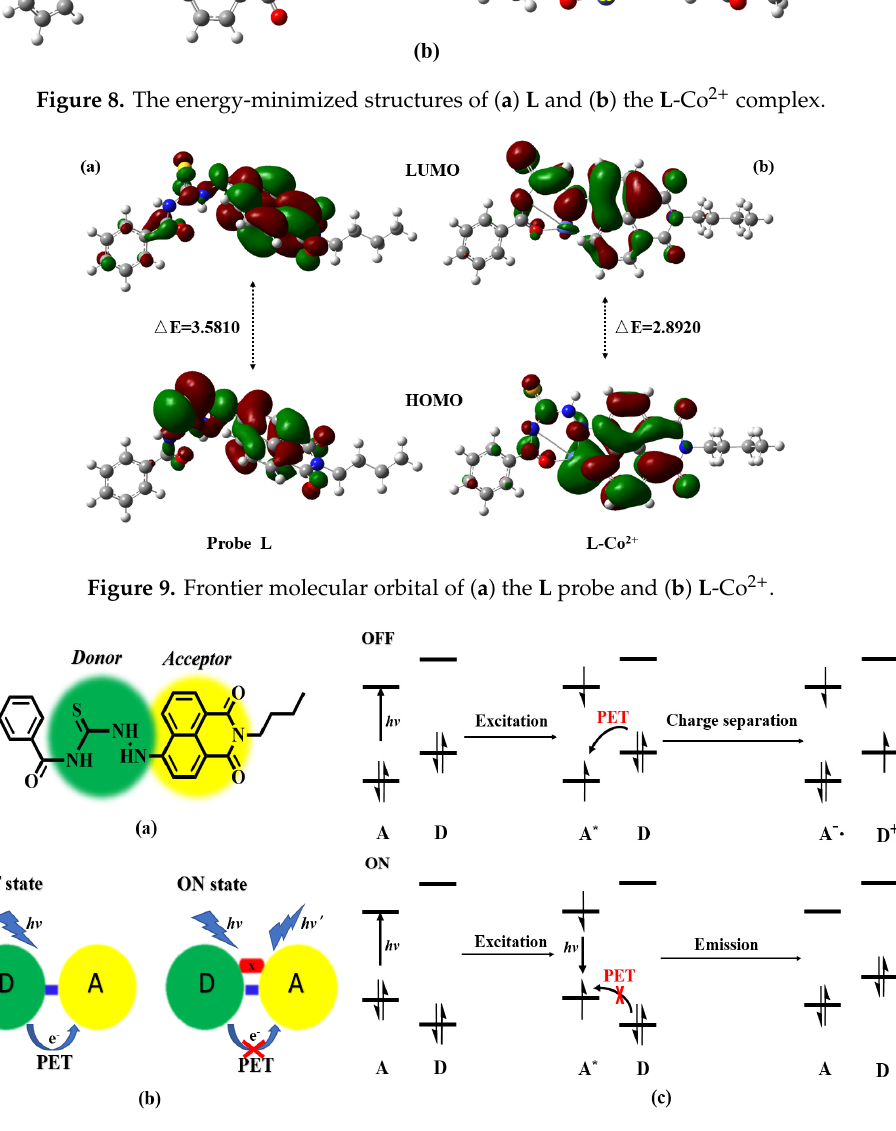
Figure 10. ( a ) Design strategy of the target L probe. ( b ) Photoinduced electron transfer (PET) in the analyte-free D–A system creates the OFF state (left); the addition of an analyte (X) blocks the PET mechanism and activates the fluorescence emission, resulting in the ON state. ( c ) Frontier molecular orbital energy diagrams of the OFF (up) and ON (down) states of an A–D System.